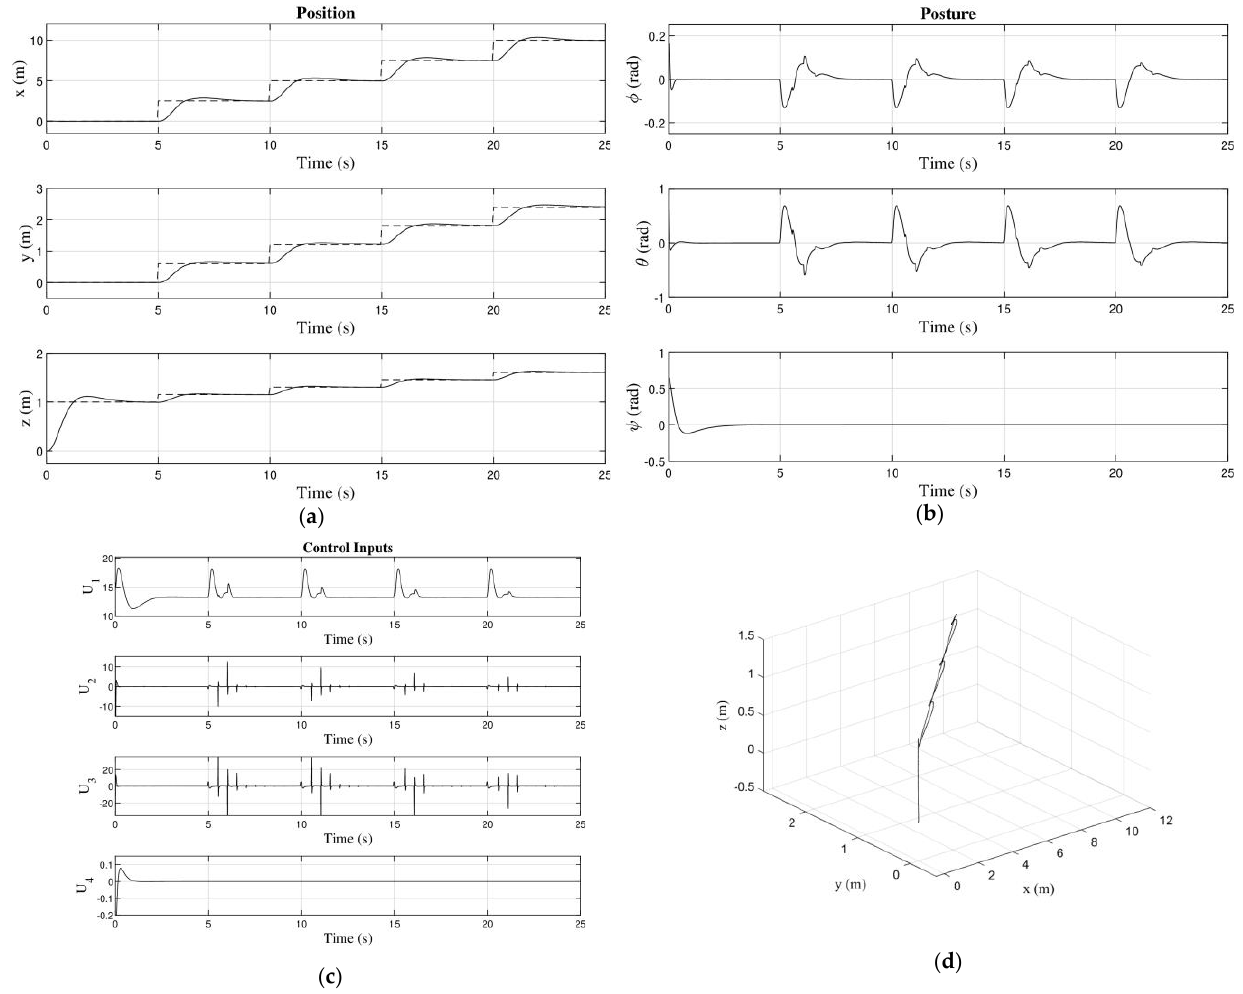
→ f is used as a reference: 7